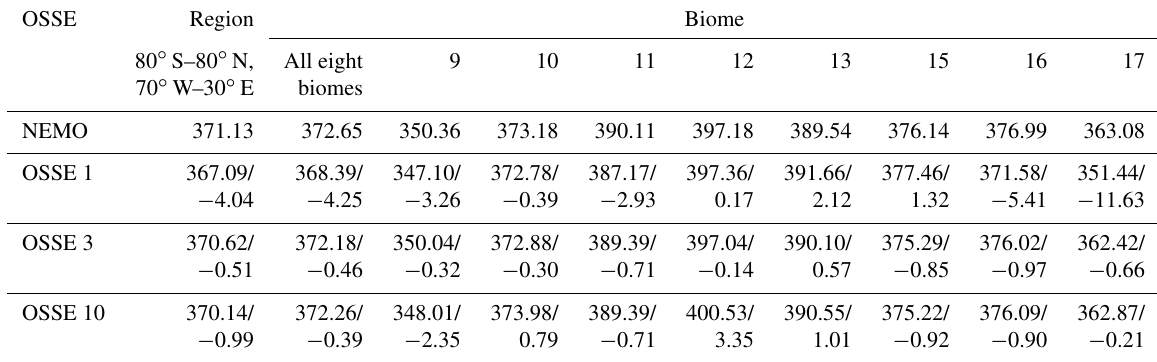
Table 7. p CO 2 averaged over the region (80 ◦ S–80 ◦ N, 70 ◦ W–30 ◦ E) and biomes from Fig. 2 for the NEMO/PISCES model; OSSEs 1, 3, and 10; and the corresponding averaged differences between OSSEs and NEMO/PISCES (in µatm). OSSE Region Biome 80 ◦ S–80 ◦